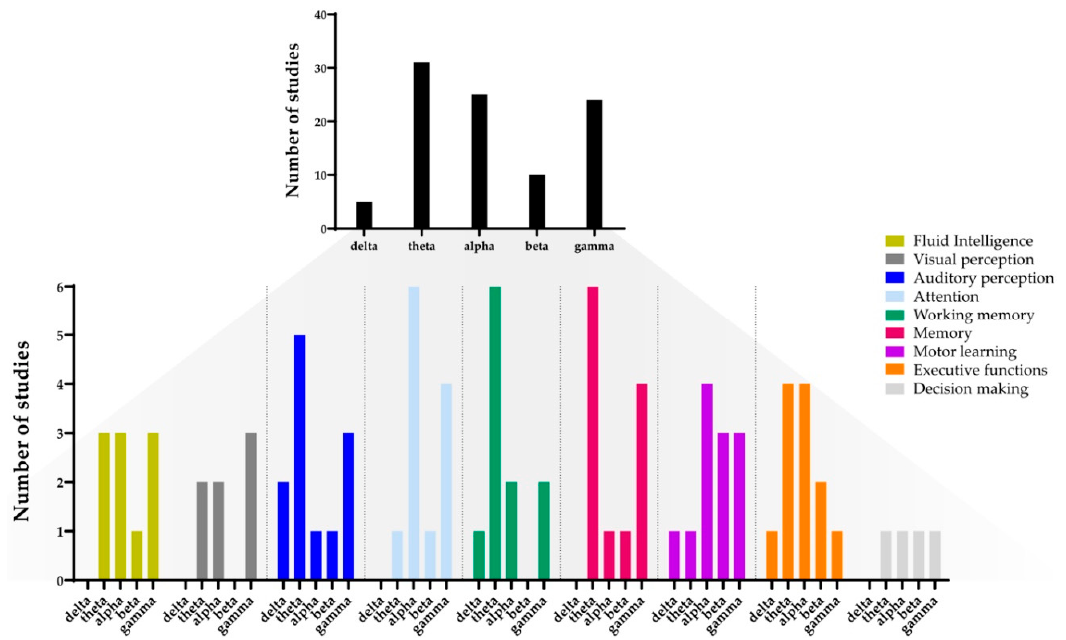
Figure 4. Number of times tACS with a certain frequency was applied in all included studies ( top ) or in each cognitive domain ( bottom ).